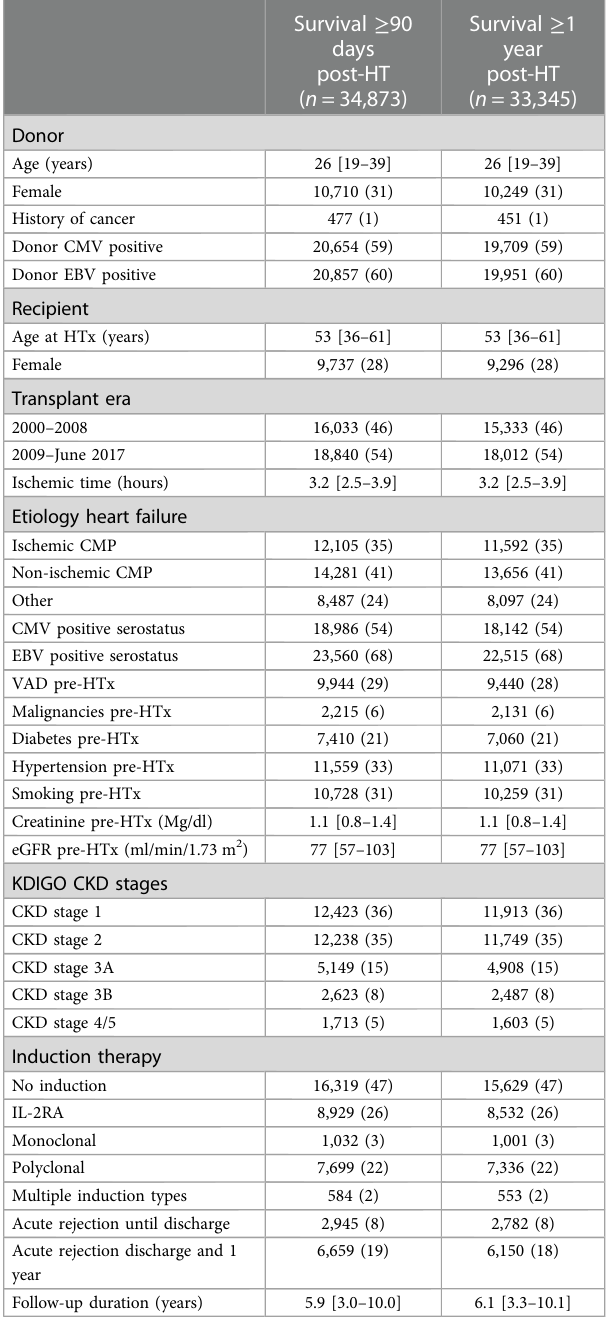
Supplementary Table S6 , and Figure S4 . Recipient CKD stage ≥ 4 was not associated with an increased risk of PTLD compared